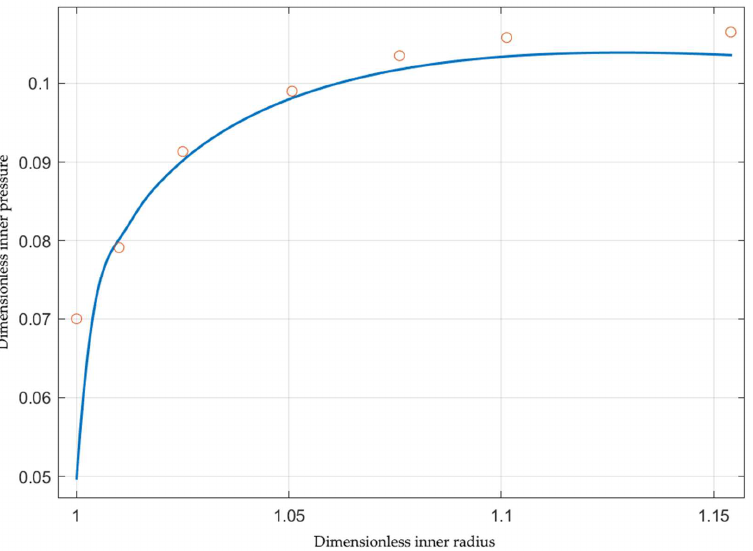
Figure 5. Comparison of the theoretical prediction of the inner pressure and experiment [24]. The solid line corresponds to the theoretical prediction and the circles to the experiment.